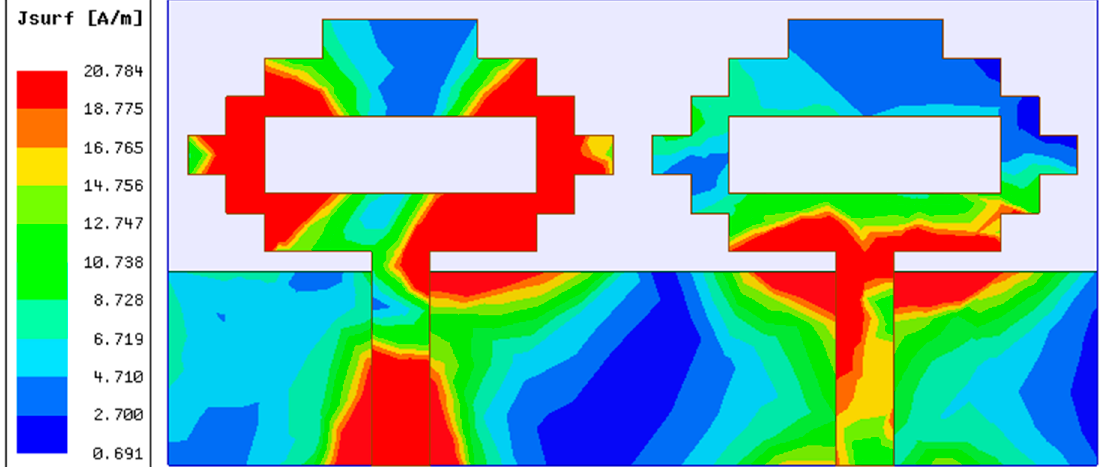
Figure 6. Two-element MIMO antenna’s current distribution for 4.75 GHz.